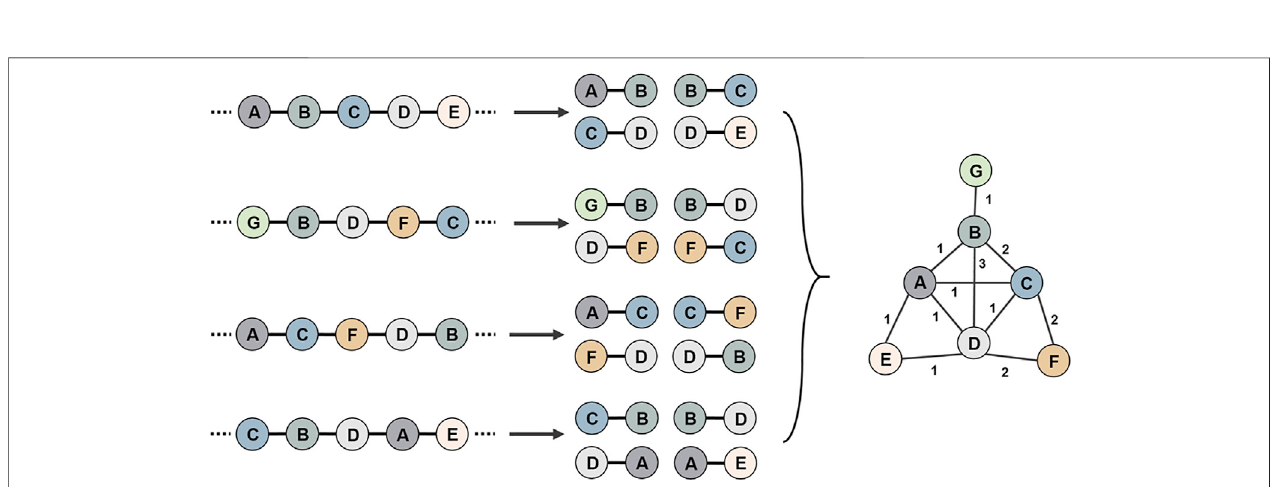
FIGURE 1 | PPA-GCN architecture. The input to the framework is the metabolic pathway network extracted from the KEGG metabolic pathways and the gene synteny network composed of the prokaryotic genomes. The graph convolutional layer attempts to construct a mapping relationship between the two input networks and iteratively uses thetraining results toupdate the inputinspired byself-supervised learning until asteadystateisreached and the fi nalassignmentoutputisobtained.